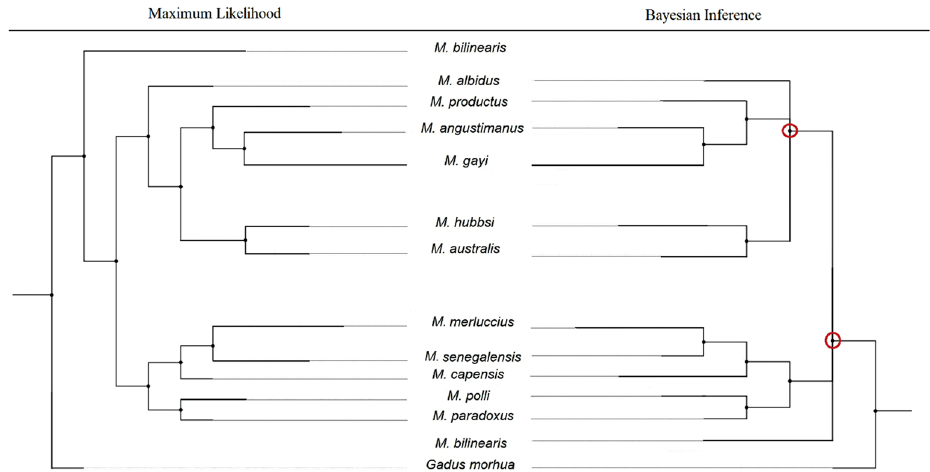
Figure 3. Comparison of reconstruction methods from a synthetic phylogeny of genus Merluccius spp. on concatenated sequences from ITS1-rDNA (HKY85 + I + G substitution model) and cyt b (GTR + G substitution model). Left: Phylogeny of genus Merluccius spp. using Maximum likelihood (- lnL = − 4244.841) after IQ-TREE 87 . Right: Bayesian tree after MRBAYES v3.2.6 86 . Circled nodes indicate topology differences between both reconstruction methods. Gadus morhua was used as